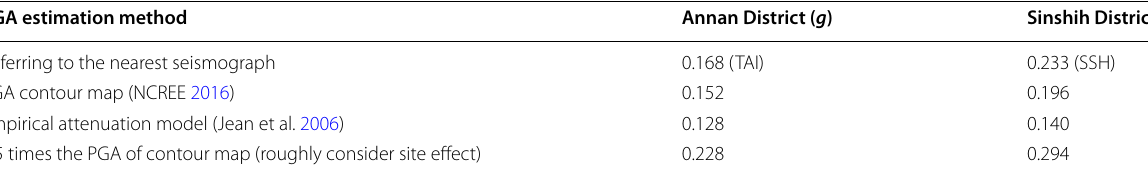
Table 3 Estimated horizontal peak ground